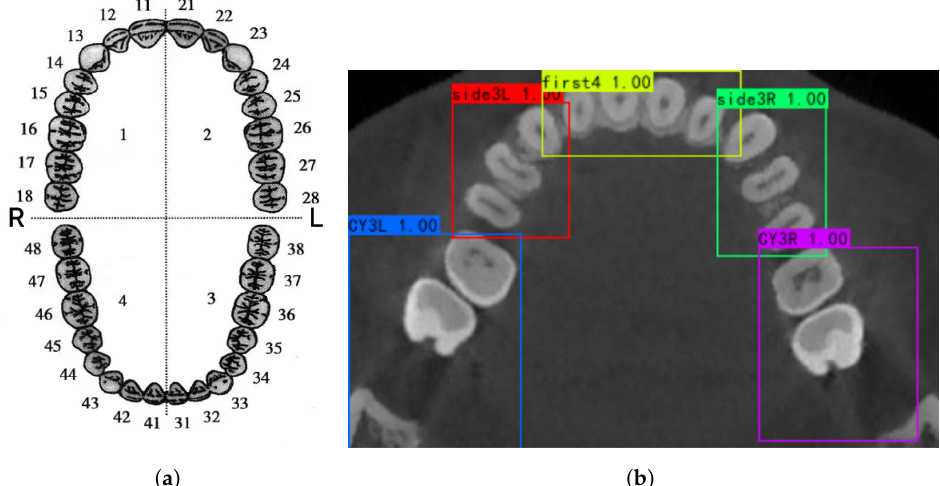
Figure 1. Definition of tooth number and tooth blocks in this research. ( a ) FDI tooth numbering system; ( b ) 5 blocks of teeth for